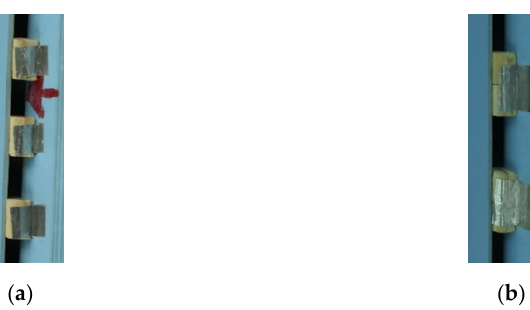
Figure 13. Injections of DCFJ312 airfoils with various RUL s. ( a ) RUL = 0.025; ( b ) RUL = 0.05.